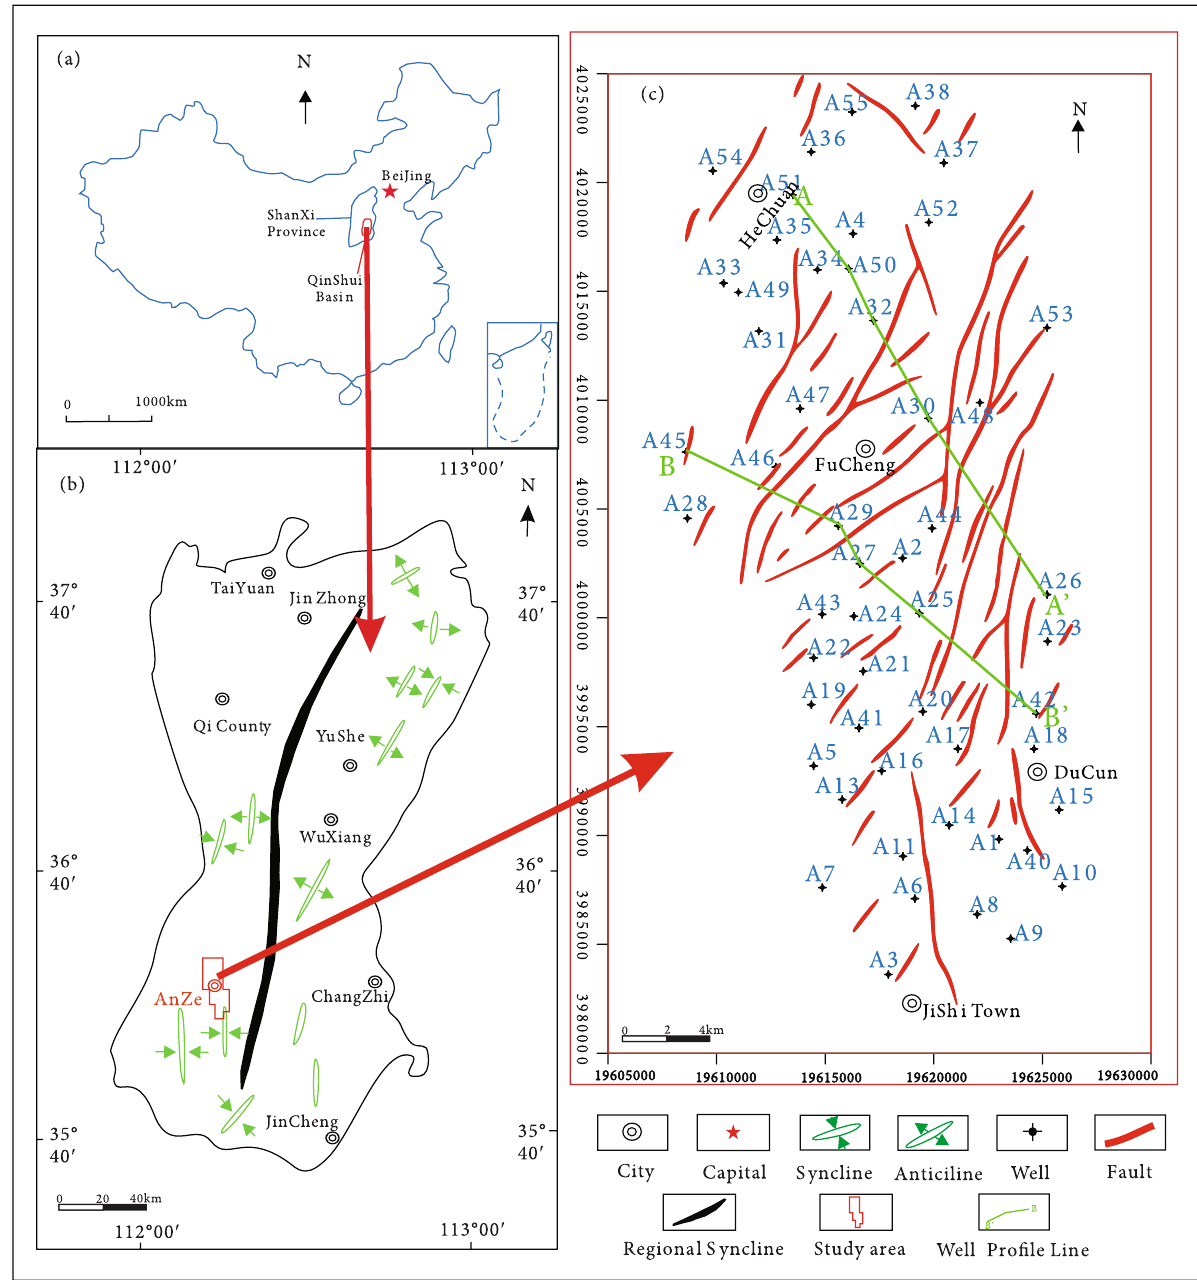
Figure 2: The location and geological structure of Anze Block, southern Qinshui Basin, Shanxi Province, China. (a) The location of Qinshui Basin. (b) The geological structure of the Qinshui Basin. (c) The geological structure of the Anze